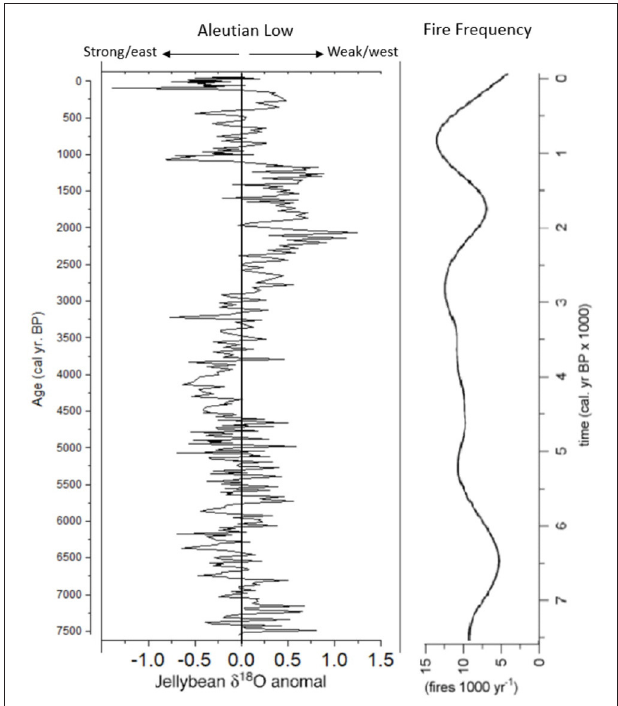
FIGURE 10 | Reconstruction of Aleutian Low strength/position using δ 18 O from Jellybean Lake ( Anderson et al., 2005) with fire frequency from Spindly Pine